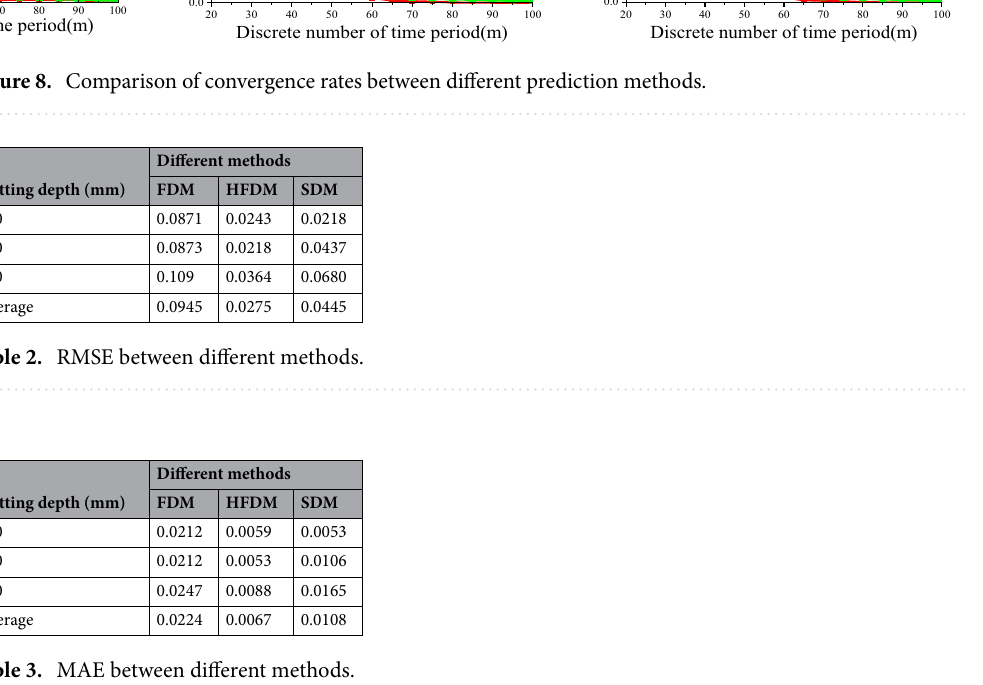
Table 3. MAE between different